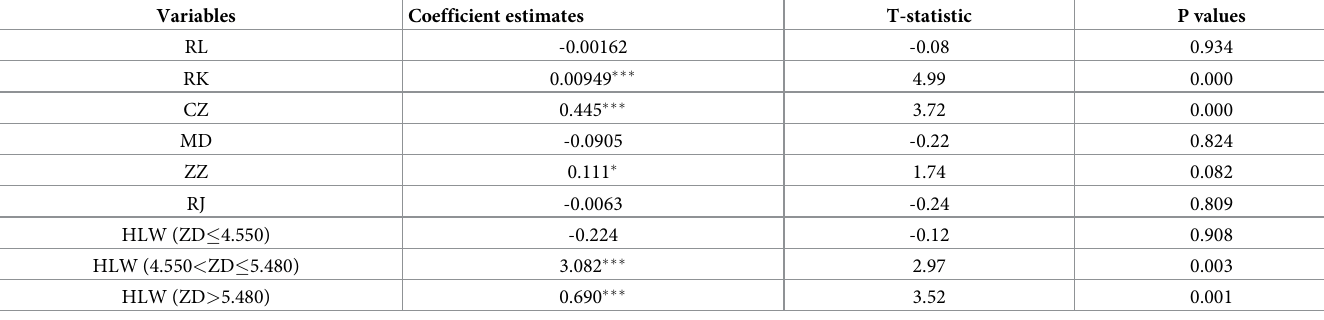
Table 8. Estimation results of the parameters of the double threshold